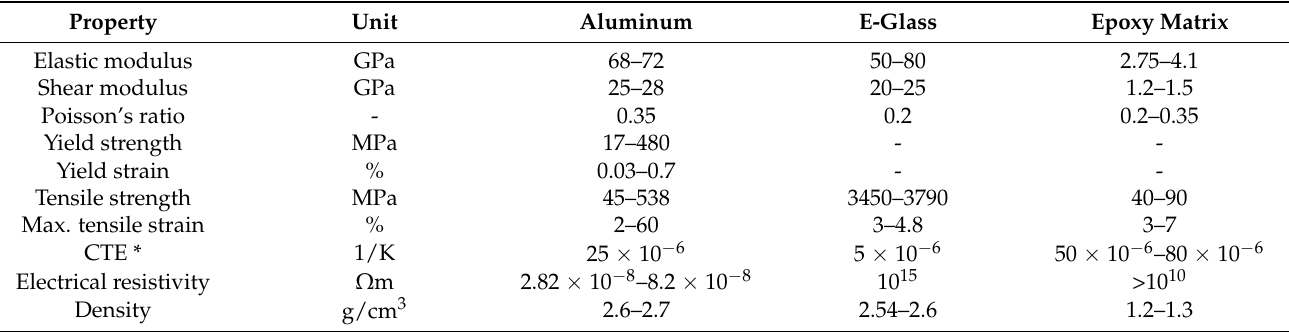
Table 1. Typical mechanical and electrical properties of aluminum (pure/alloys), E-glass and epoxy matrix [30–33].